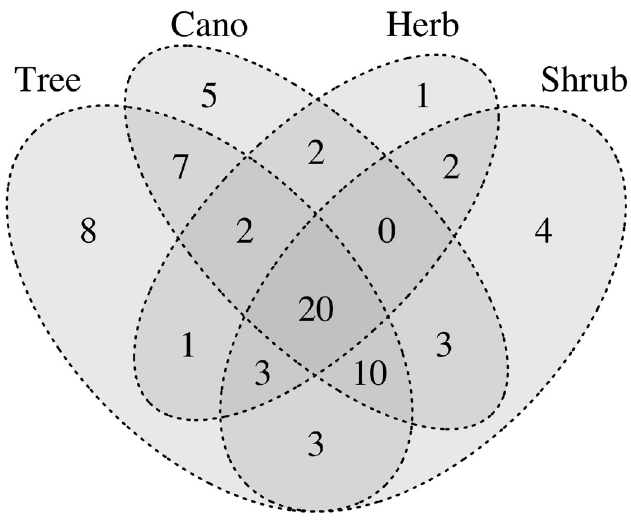
Fig. 13. Distribution of the species in the different vegetation